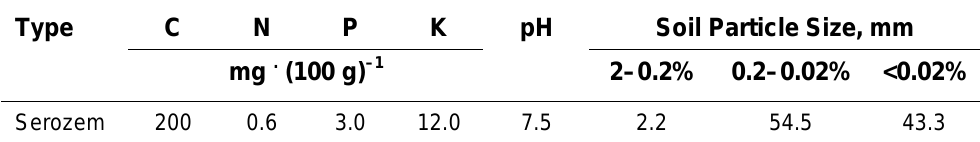
Soil Chemical Properties and Soil Particle Distribution at 0- to 30-cm Soil